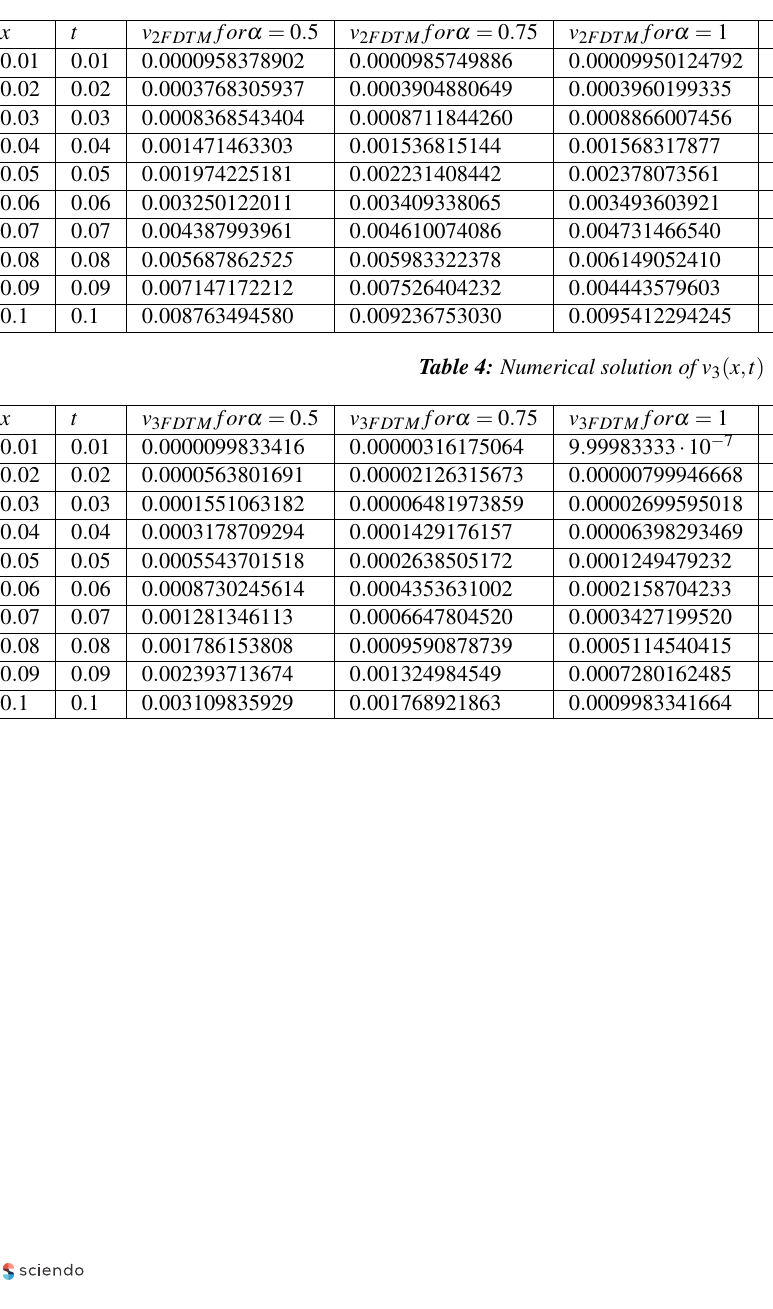
Table 3: Numerical solution of v 2 ( x , t )